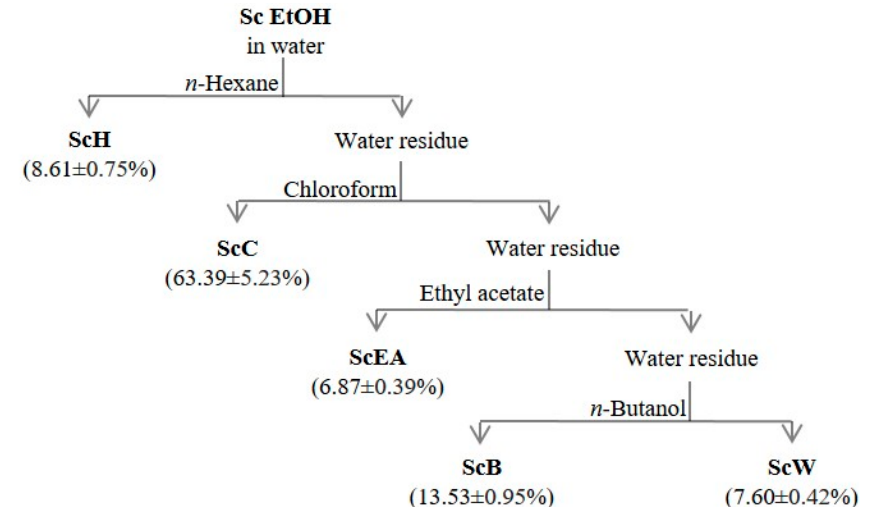
Figure 1. Extraction yields of S. clivicolus EtOH extract partitioned fractions. Results were expressed as mean ± standard deviation of the triplicate experiments. Samples are crude ethanol extract (Sc EtOH), n -hexane fraction (ScH), chloroform fraction (ScC), ethyl acetate fraction (ScEA), n -butanol fraction (ScB), and water fraction (ScW).